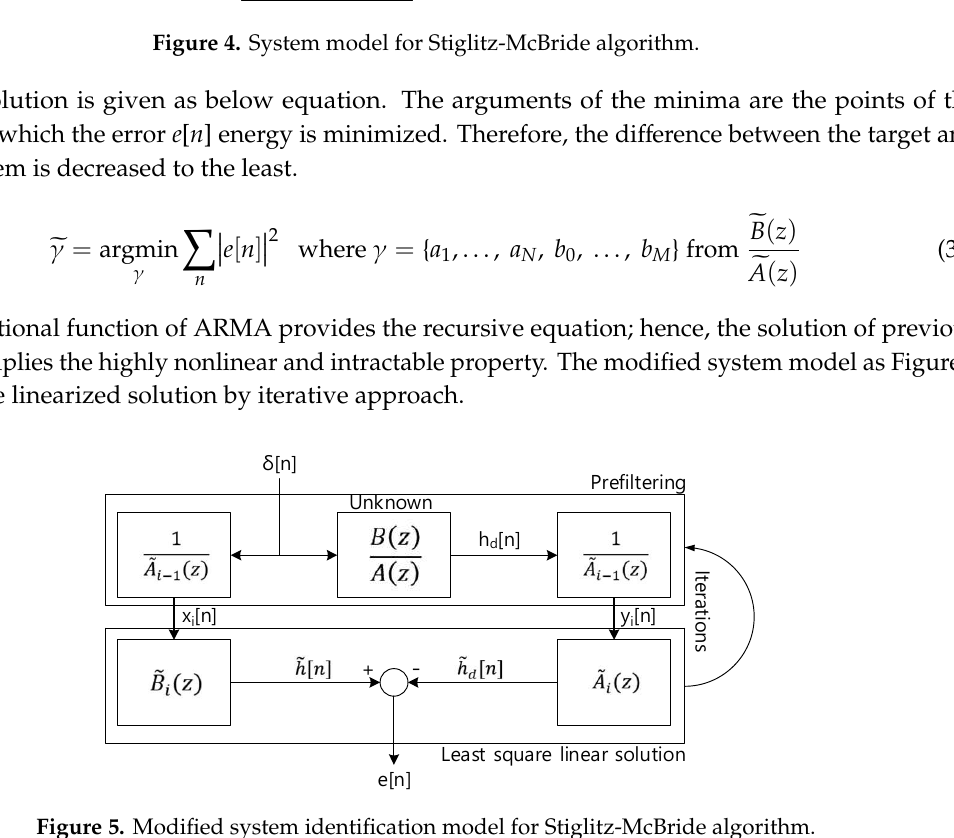
Figure 4. System model for Stiglitz-McBride algorithm.